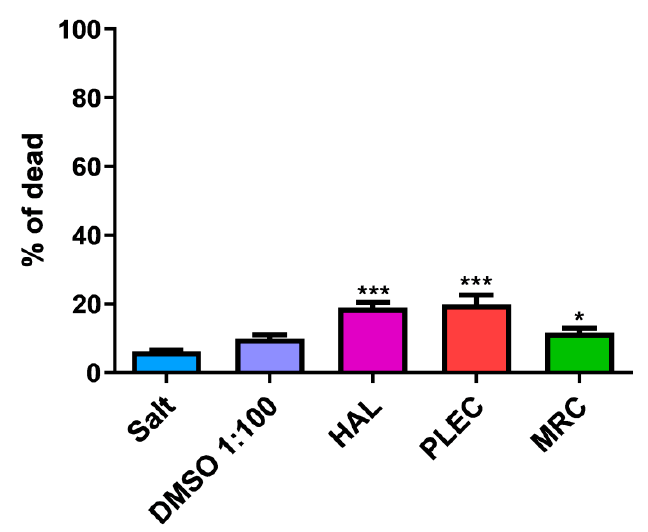
Figure 11. Mortality rate (%) of Artemia salina after 24 h exposure to HAL, PLEC and MRC from P. ornatus. Values are expressed as the mean ± SD (n = 3). * p < 0.05; *** p < 0.001 comparison salt vs. HAL, PLEC and